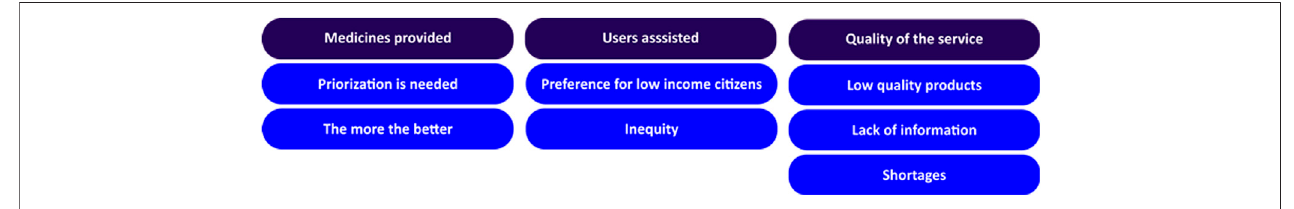
FIGURE 3 | Categories identi fi ed through thematic analysis of reports of group